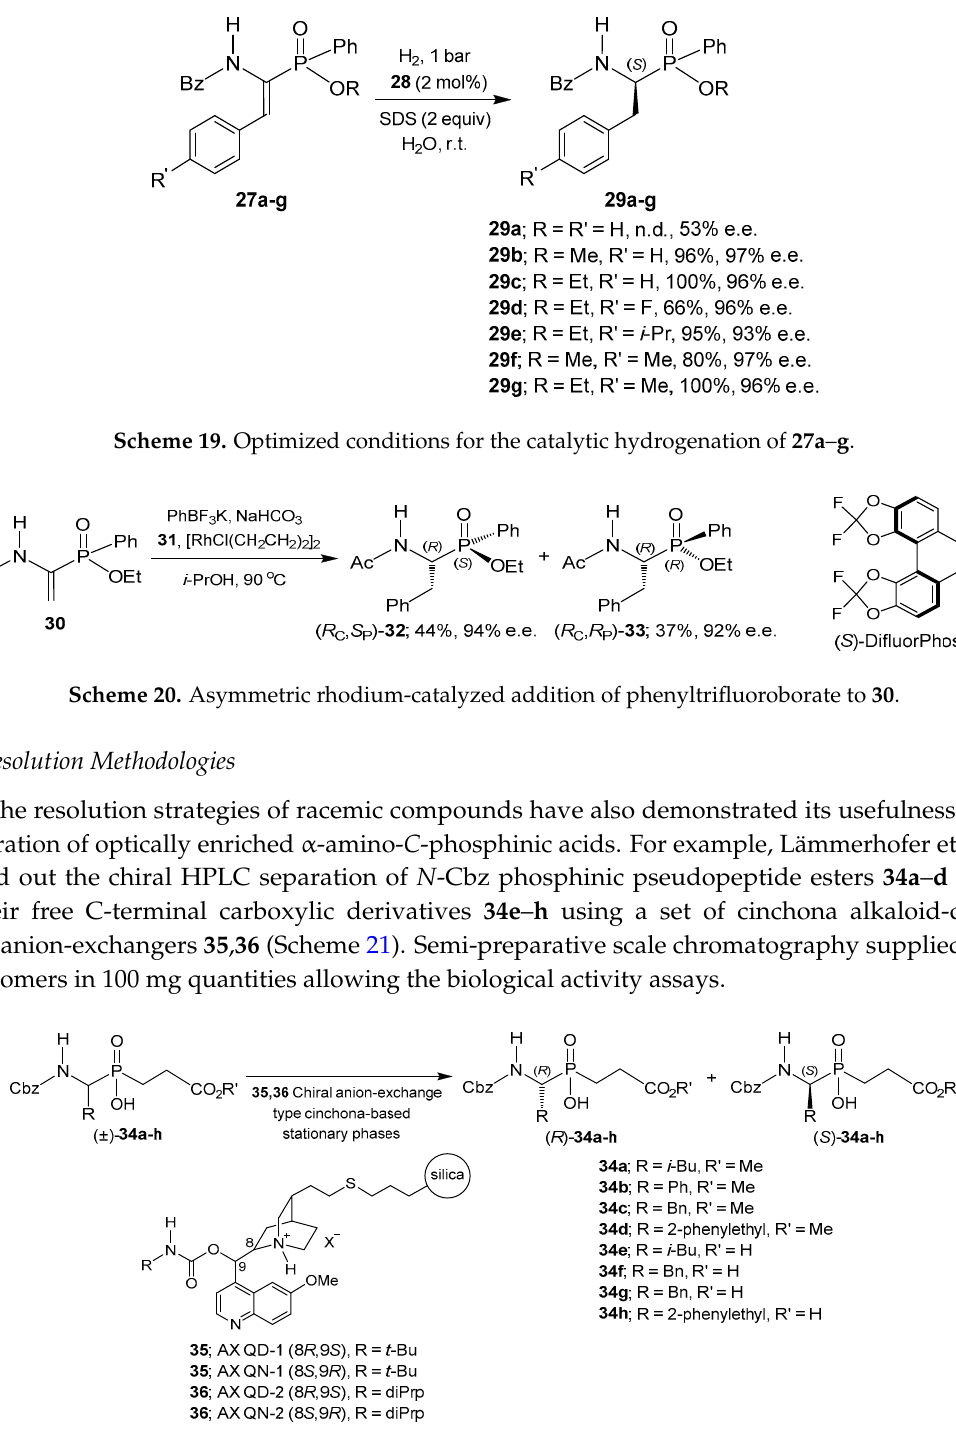
Scheme 22. Capillary electrochromatography (CEC) method for the separation of (±)- 37a , b and (±)- 38a , b . Taking into account that phosphinic dipeptides, although tested as stereoisomeric mixtures, are considered amongst the most potent inhibitors of bizinc cytosolic leucine aminopeptidase (LAP) [62], Mucha, et al. [63] carried out the chiral HPLC separation of all stereoisomers of phosphinic dipeptide homophenylalanyl-phenylalanine derivative 40 and 41 on a quinidine carbamate modified silica stationary phase 42 (Scheme 23). Significant differences in inhibition of the unprotected derivatives 43 and 44 show the importance of the molecular stereochemistry in spatial interaction with the enzyme active site. In another example, Ragulun and Rozhko [64] reported the preparation of the optically pure α -aminobenzyl hydroxymethyl phosphinic acid ( R )- and ( S )- 45 , where the key step was a biocatalytic resolution. Thus, the racemic α -aminobenzyl hydroxymethyl phosphinic acid (±)- 45 , obtained from the hydroxymethyl phosphinic acid, was acylated with phenylacetyl chloride and KOH in water to obtain the N -phenylacetyl derivative 46 in 63% yield, which by hydrolysis using penicillin amidase (PcAm) as the biocatalyst, afforded the enantiomerically pure ( R )- 46 in 62% yield and the deacylated product ( S )- 45 in 57% yield. Finally, hydrolysis of compounds ( R )- 46 with 6 N HCl at reflux followed by treatment with propylene oxide, provided the α -amino- C -phosphinic acid ( R )- 45 in 84% yield (Scheme 24).